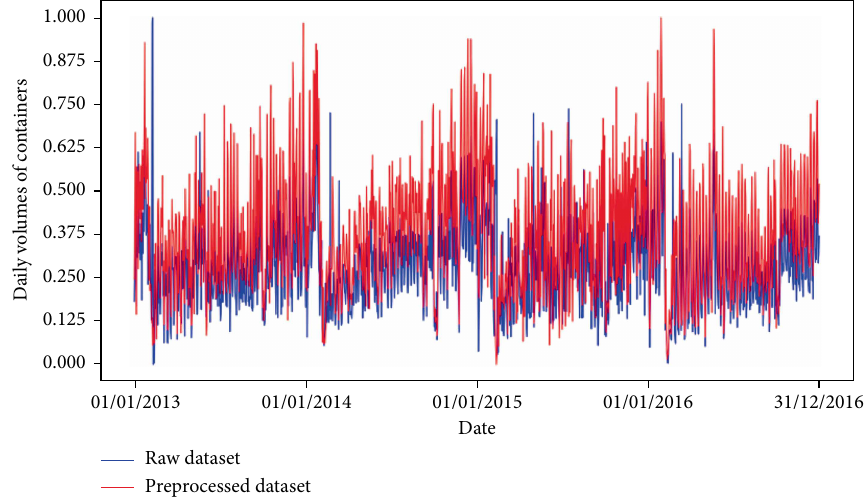
Figure 5: The normalized dataset of daily container volumes from 2013 to